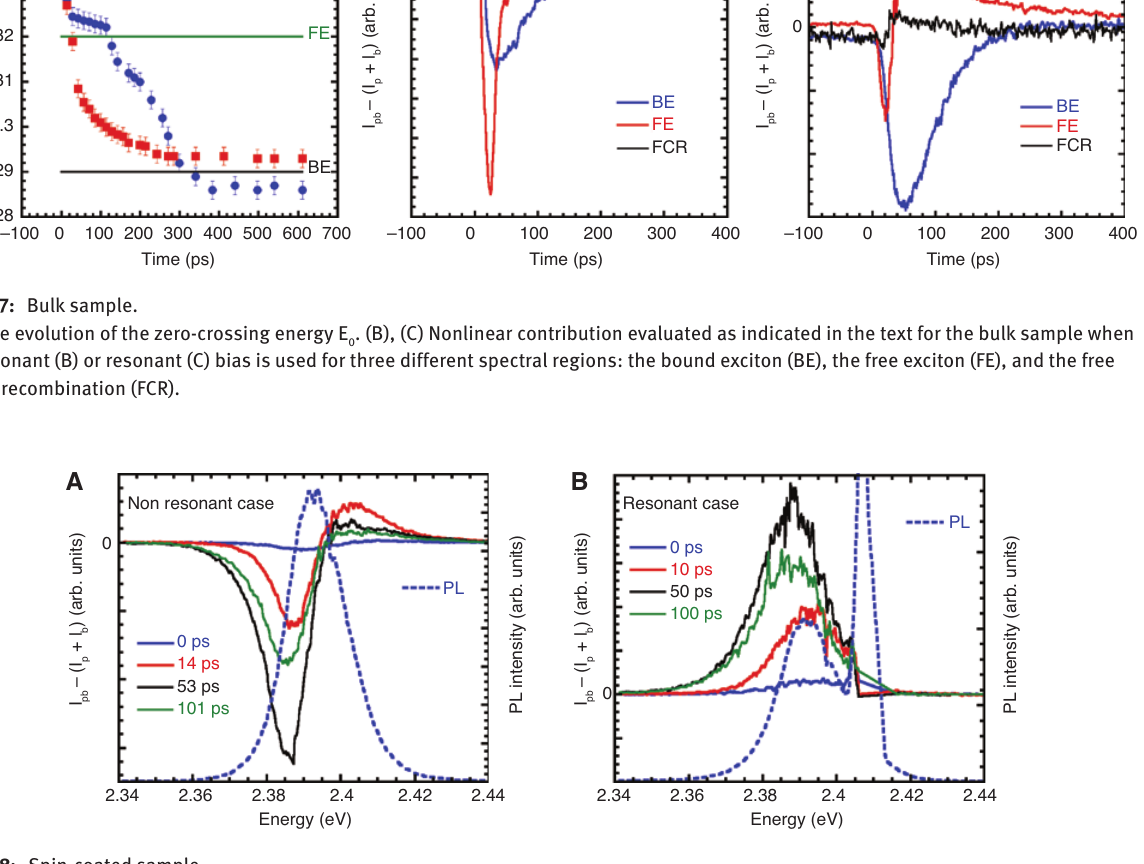
Figure 8: Spin-coated sample. (A) Nonlinear response for the nonresonant bias. (B) Nonlinear response for the resonant bias. The dashed line (blue) corresponds to the PL